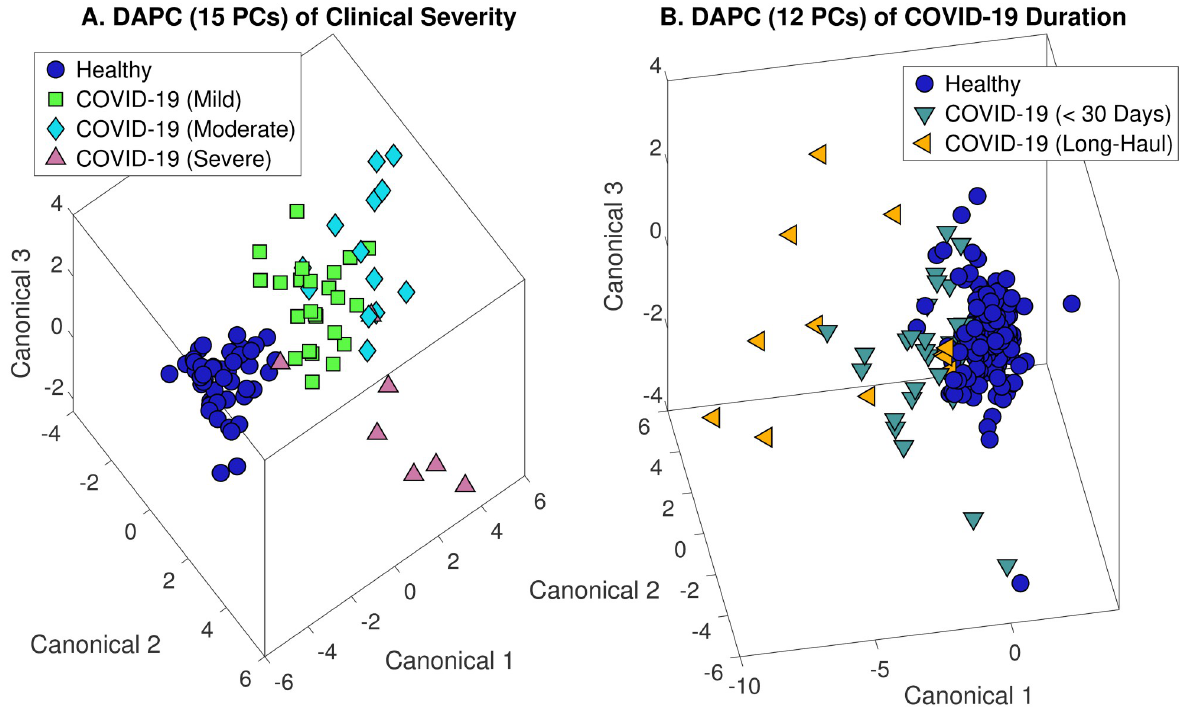
Fig 4. DAPC models demonstrating cluster separation of COVID-19 Raman urine spectra by clinical severity (A) and duration of symptoms (Long-Haul) (B).